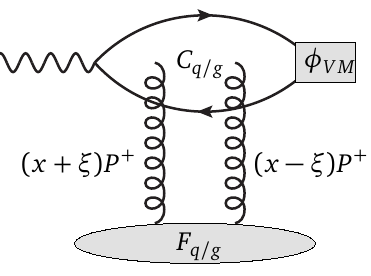
Figure 5: Exclusive vector meson am- plitude in the